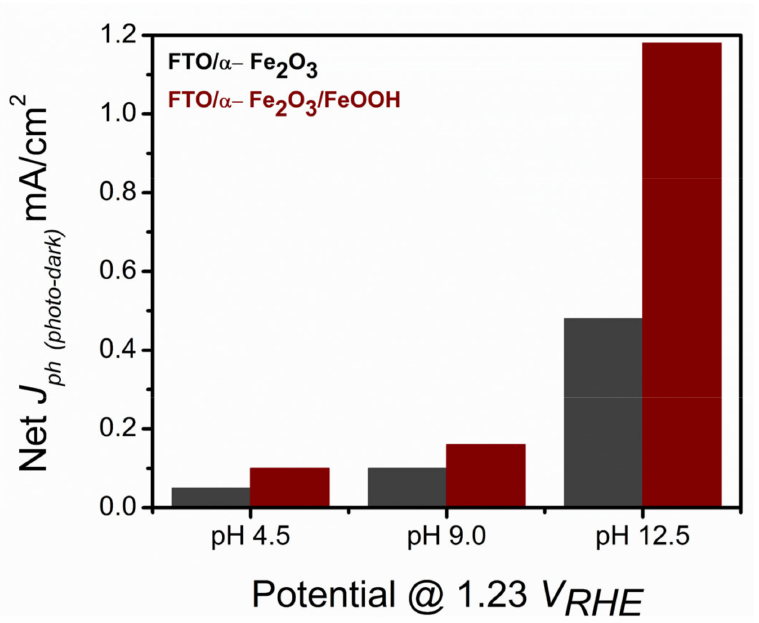
Figure 1. Net photocurrent responses for bare and modified hematite photoanodes for water oxida- tion at 1.23 V RHE